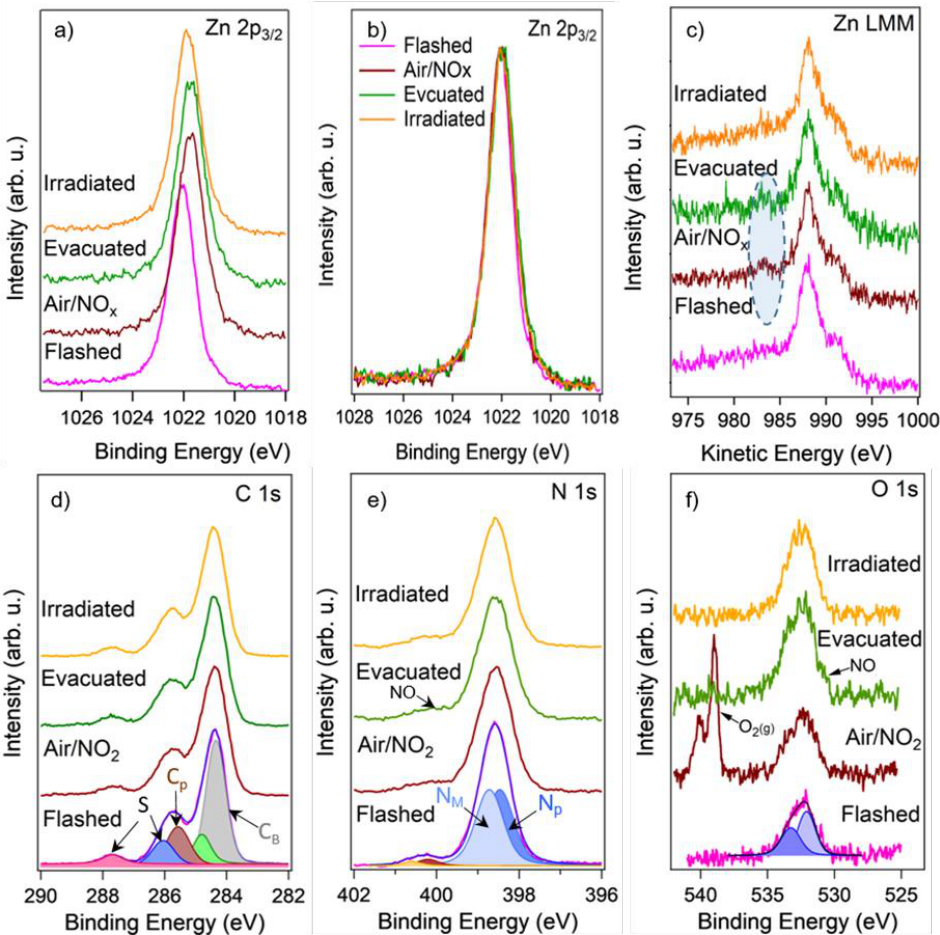
Figure 8. Comparison of height-normalized Zn 2p 3/2 XPS spectra acquired from the ZnPc layer in UHV after the flash (pink), in the presence of 1 mbar air/NO 2 (brown), after the evacuation back to UHV (green), and after the illumination by laser (orange) before ( a ) and after ( b ) the elimination of the band bending. ( c ) Comparison of height-normalized Zn LMM Auger spectra measured together with the Zn 2p 3/2 spectra at the same conditions. ( d , e ) Comparison of height-normalized C 1s and N 1s XPS spectra acquired together with the Zn 2p 3/2 spectra at the same conditions. ( f ) Non-normalized (as measured) O 1s XPS spectra acquired with the Zn 2p 3/2 spectra at the same conditions.